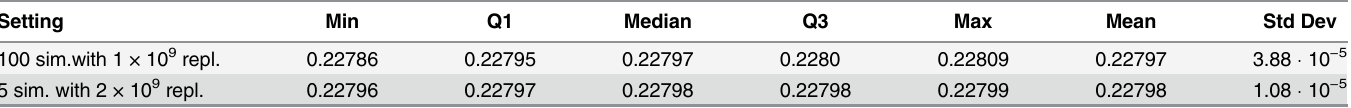
Table 1. Distribution of the slope parameter b of simulated Z 2 max distributions by different simulation settings. sim. = simulations, repl. = replicates. Setting Min Q1 100 sim.with 1 × 10 9 repl. 5 sim. with 2 × 10 9